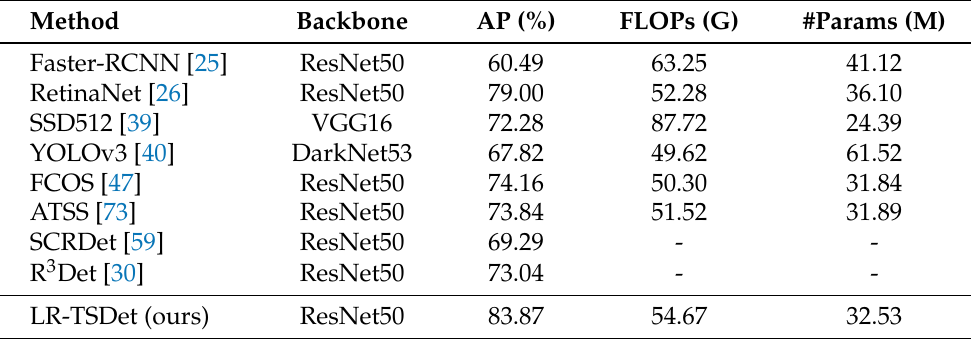
Table 5. Comparisons with other typical methods on the GF1-LRSD